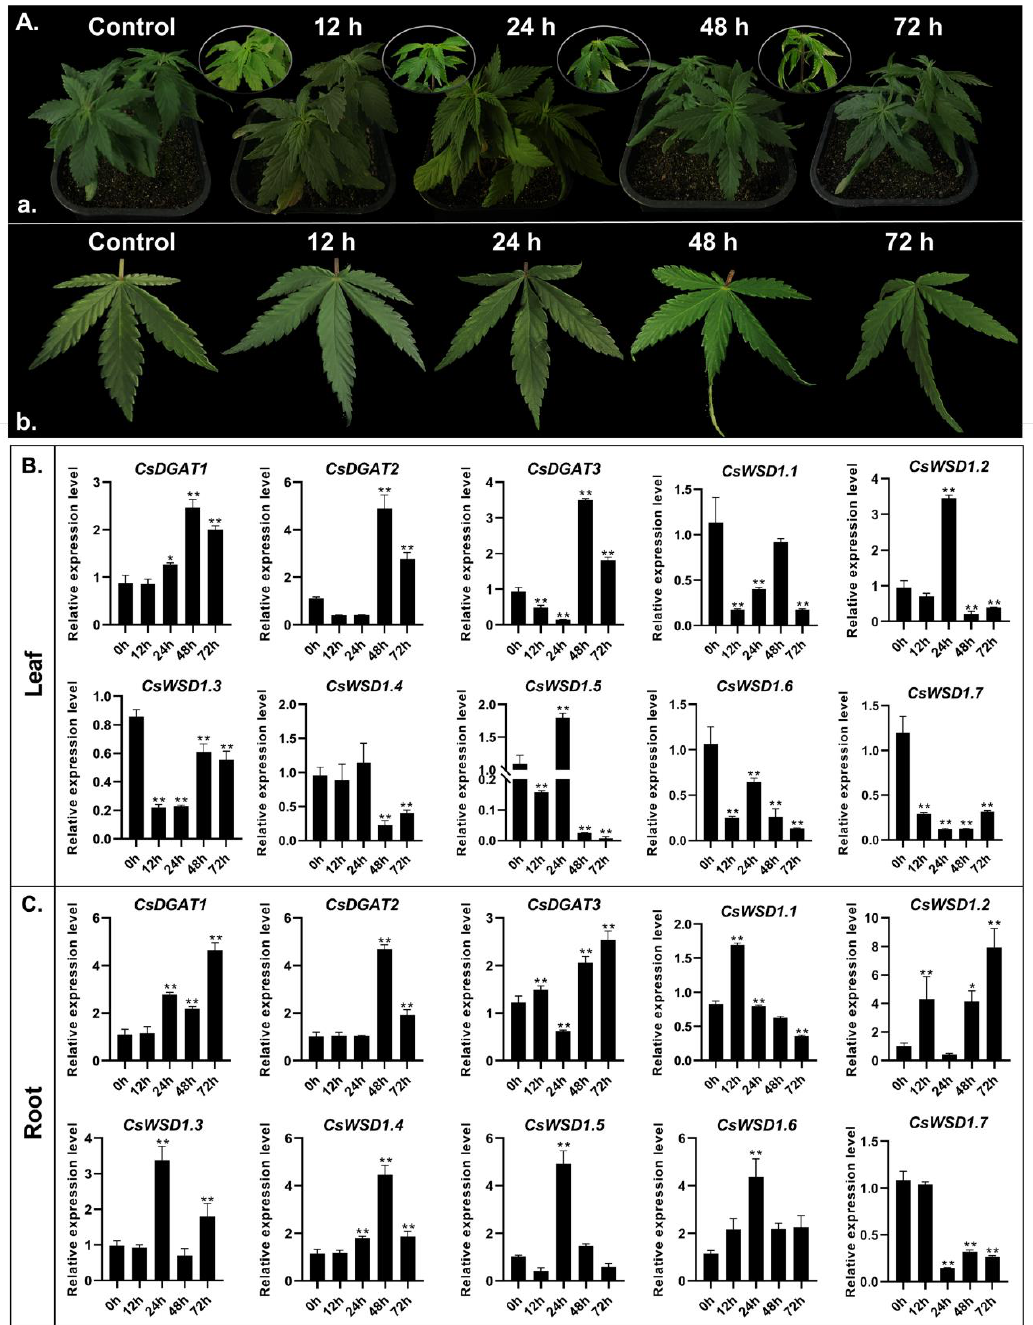
Figure 8. Phenotype and CsDGAT expression pattern analysis under cold stress response in C. sativa .